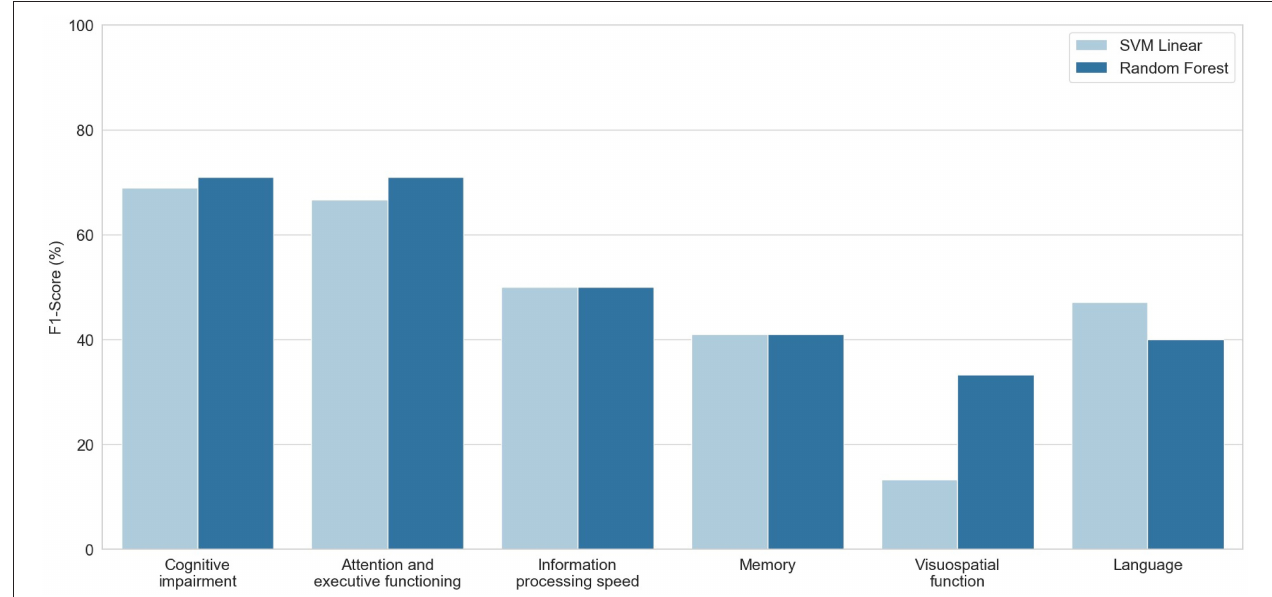
FIGURE 2 | F1-Scores (y-axis) obtained for each classification task (x-axis) using Support Vector Machine with linear kernel (SVM Linear, light blue) and Random Forest (blue) algorithms.